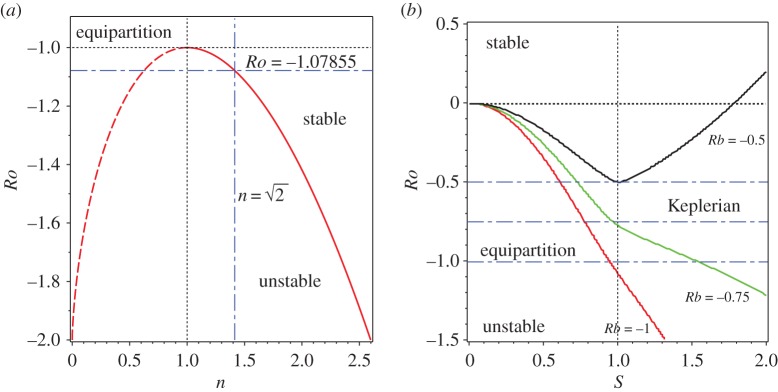
(a) Stability diagram in (n,Ro)-plane at S=1 and Rb=−1 according to the criterion (3.11). The dashed line shows the non-physical branch of the neutral stability curve (3.13) corresponding to 0<n<1. (b) The critical value of Ro at the onset of the Hamilton–Hopf bifurcation as a function of S when n=−2Rb [43] at various values of Rb. (Online version in colour.)